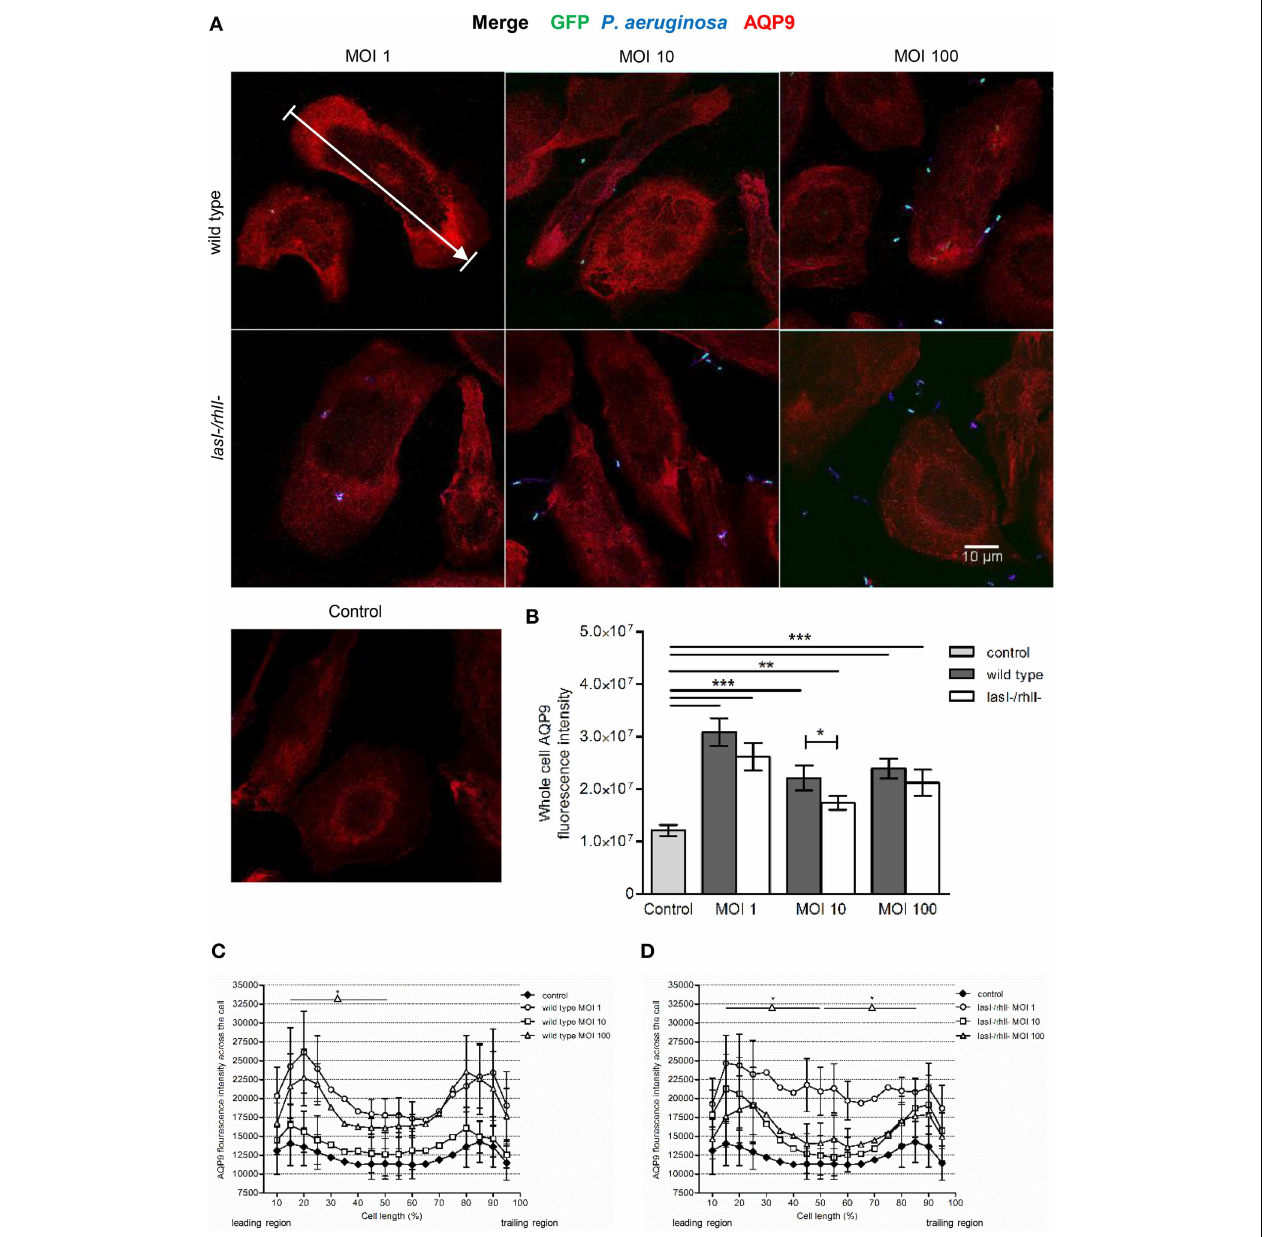
FIGURE 4 | Effects of P. aeruginosa on the cellular distribution of AQP9. (A) Macrophages were infected with GFP (green) wild type P. aeruginosa, the lasI-/rhlI- mutant, or non-infected (Control), stained for P. aeruginosa (blue), AQP9 (red) and analyzed by LSCM. The data are from one of at least three independent experiments. Bar 10 µ m. (B) Quantification of AQP9 immunofluorescence intensity measured as a total integrated intensity of whole macrophage area, of at least 30 cells for each condition. Data are from at least three experiments performed at separate days from different donors. Columns represent means ± SE. Significant differences are indicated when ** P < 0 . 01 and *** P < 0 . 0001 , as analyzed by two-tailed unpaired Student’s t -test. (C,D) Quantification of AQP9 immunofluorescence intensity profile measured across the cells in the direction of polarization as indicated by white arrow in (A) . Significant differences are indicated when * P < 0 . 05 , as analyzed by one-tailed unpaired Student’s t